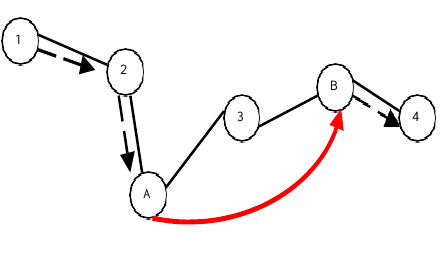
Figure 3: Representation of the wormhole